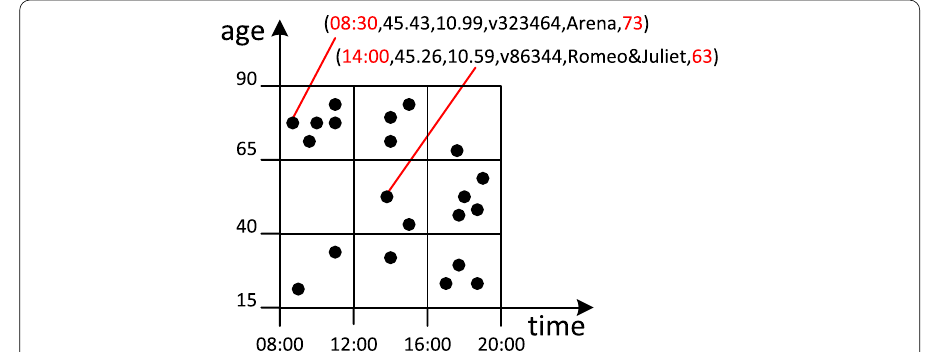
Fig. 2 Example of dataset represented as a set of points in a k -dimensional